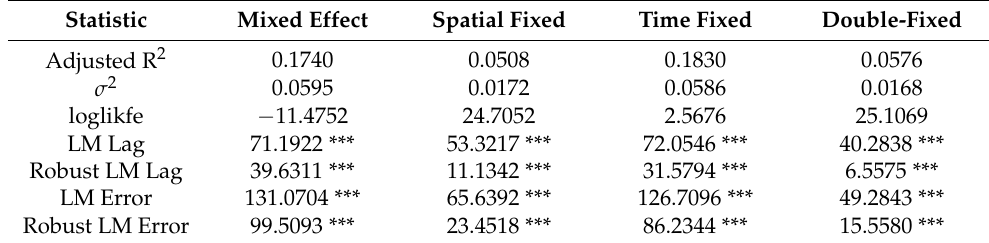
Table 4. The non-spatial panel model test results of the